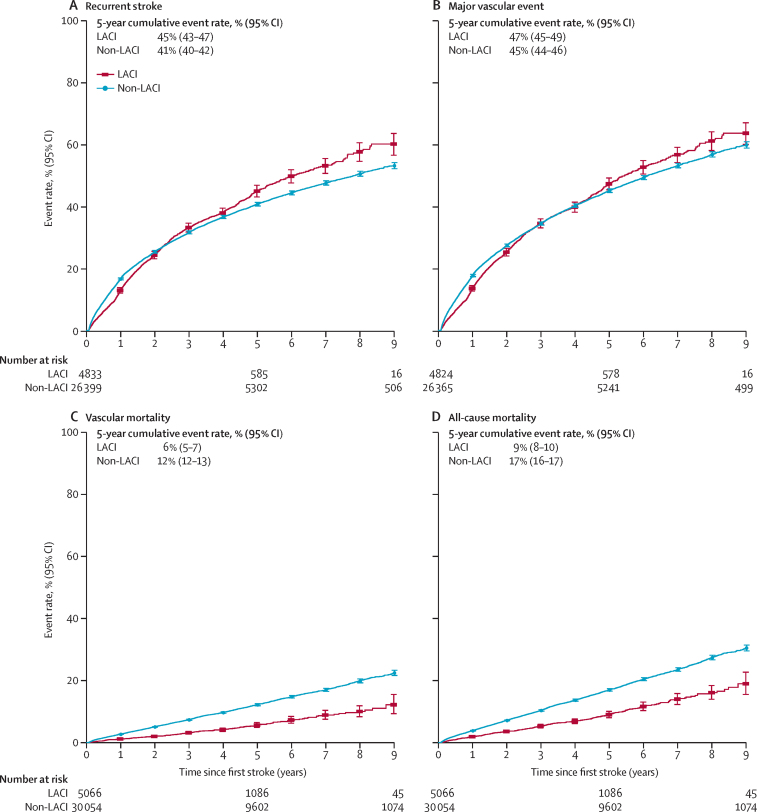
Estimated cumulative event rates of recurrent stroke, major vascular events, vascular mortality, and all-cause mortality from 28 days after first ischaemic stroke of different subtypesPlotted lines show the cumulative incidence, starting with the date of first stroke. Deaths from any cause were treated as competing risks. Participants experiencing an event or death within 28 days following a first stroke were excluded. Only participants whose first stroke was ischaemic stroke were included. LACI=lacunar infarction.